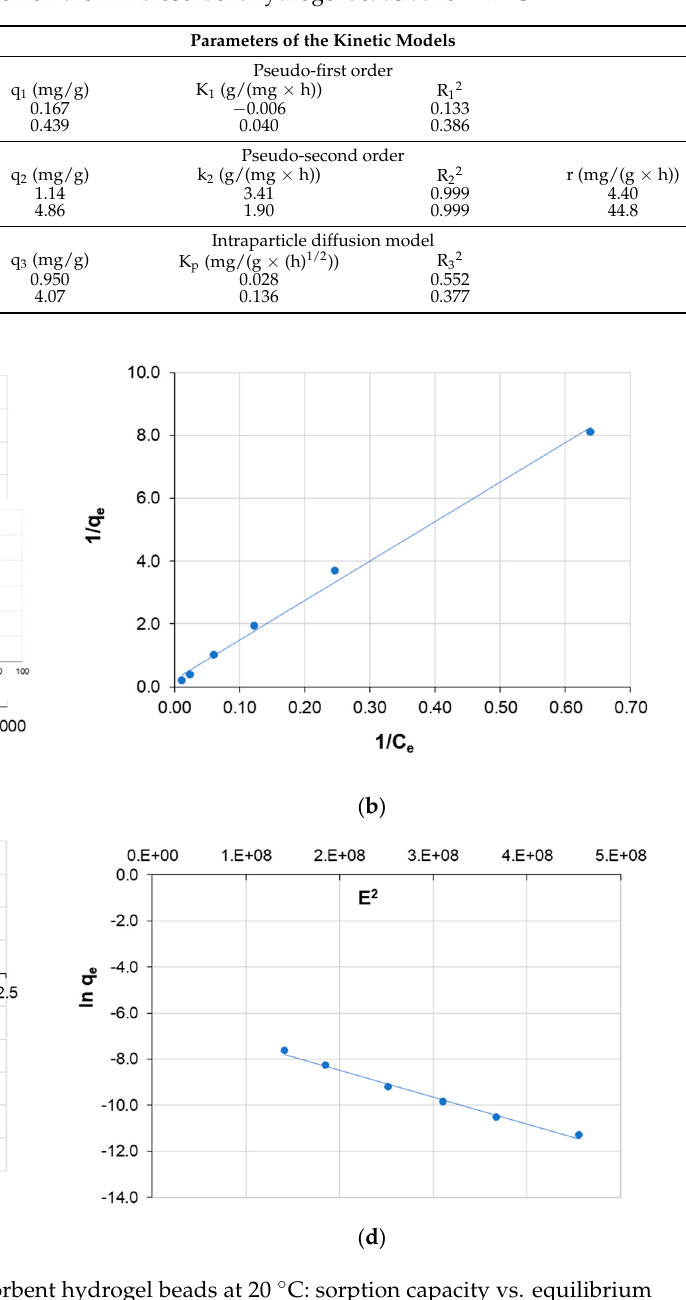
Table 2. Kinetic parameters for boron sorption on the Mn-biosorbent hydrogel beads at 20 ± 1 ◦ C.